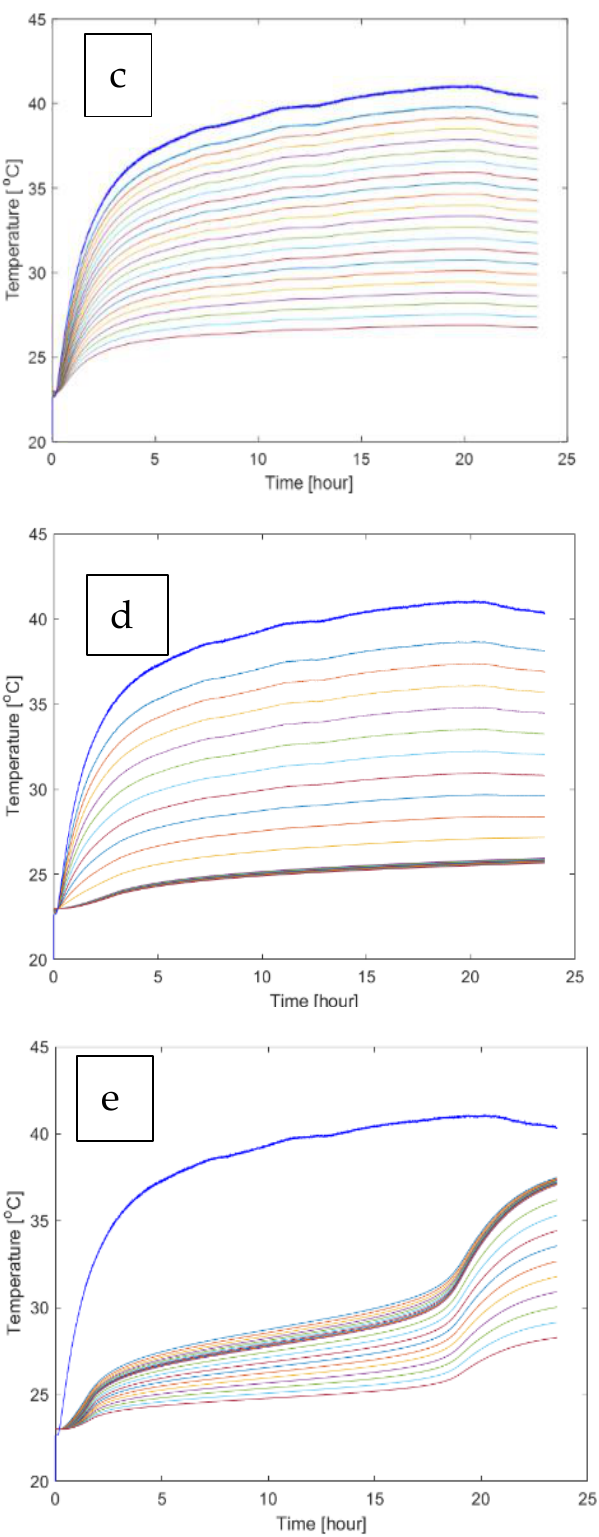
Figure 11. Temperature profiles from simulations for the two-layer configurations c–e. The lumped curves correspond to the temperature profiles over the PCM layer. The blue curve is the air temperature inside the hotbox. The other curves represent a temperature profile at different tenths of the XPS layer.